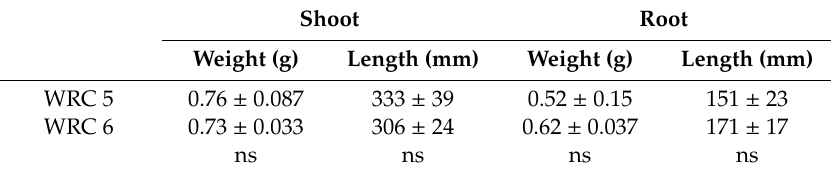
Table 3. Initial growth of WRC 5 and WRC 6 at the seedling stage. Data are shown as the mean ± SD of four to five replicates. ns indicates that there was no significant difference between WRC 5 and WRC 6 (Student’s t -test).